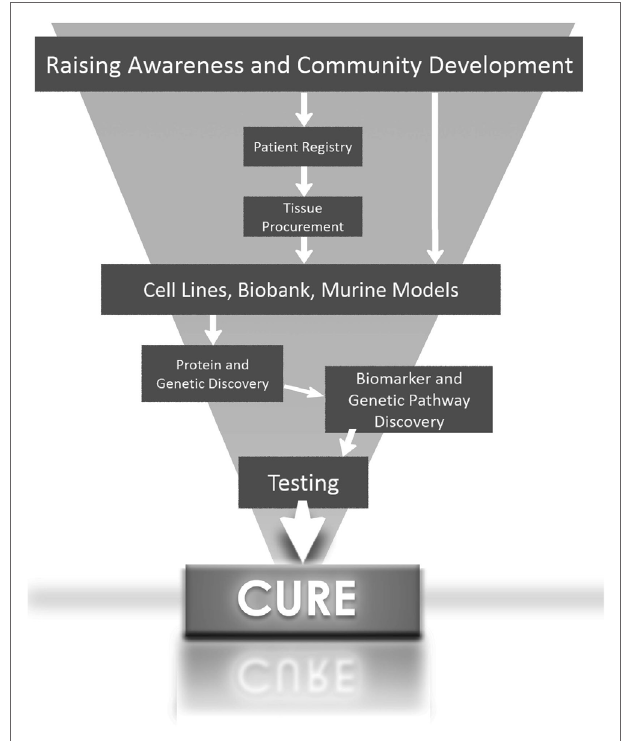
FiGUre 1 | roadmap to finding a cure for hepatoblastoma